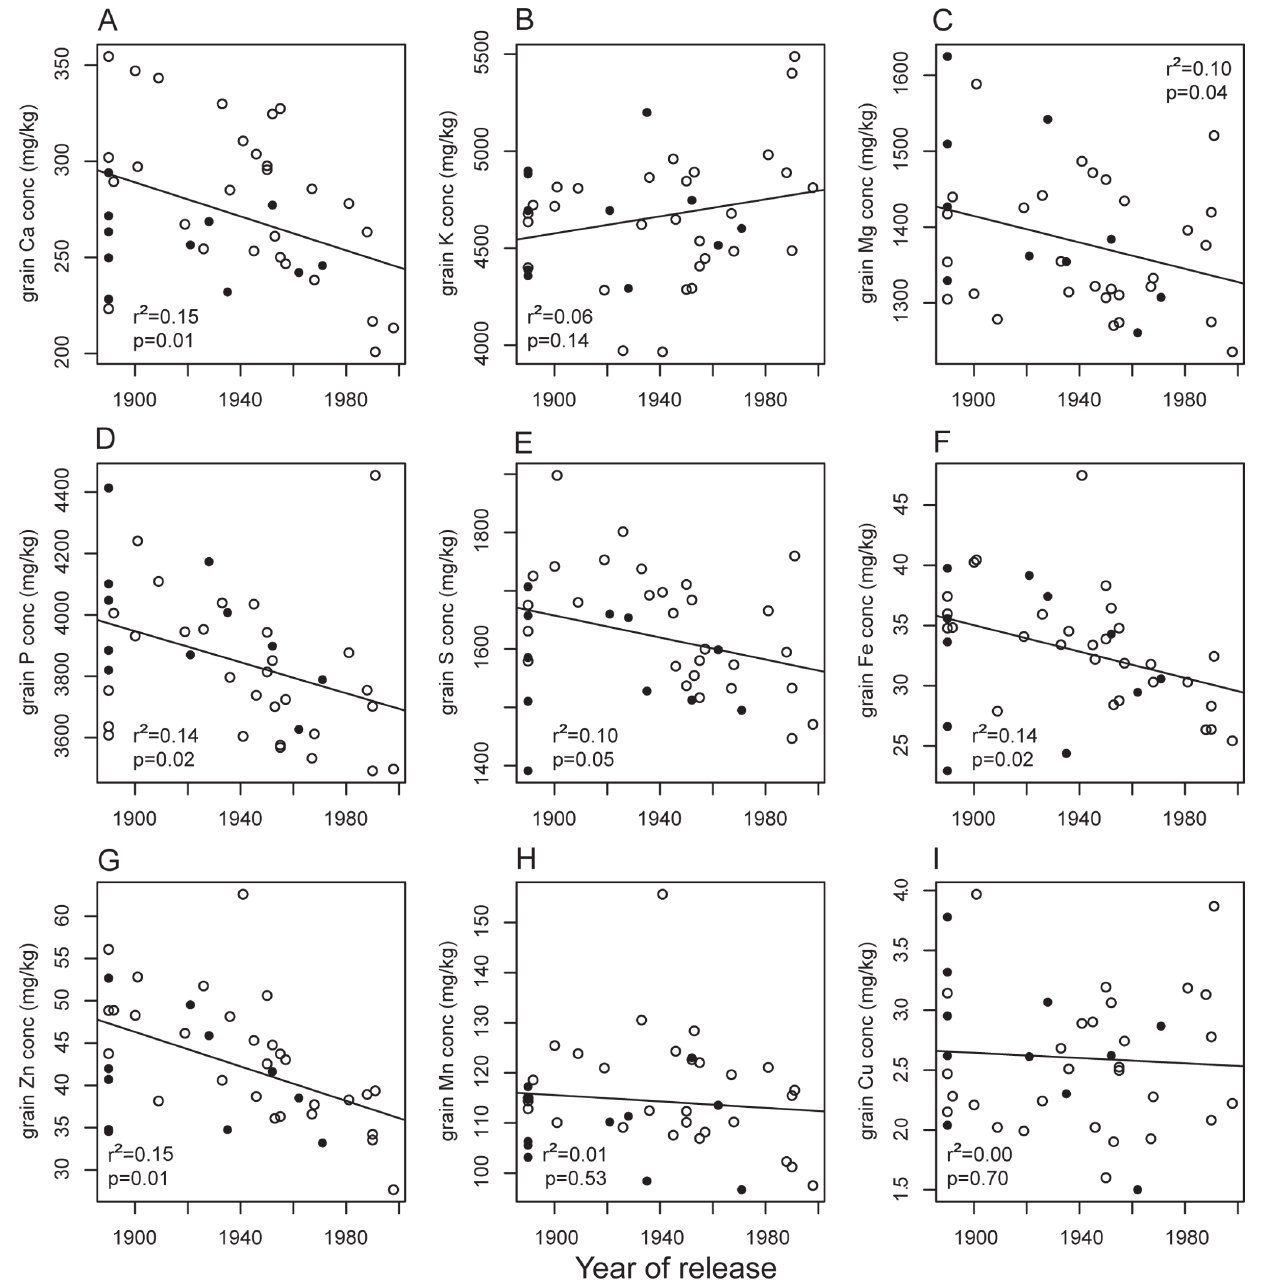
Figure 4. Changes in grain mineral concentrations over time. Filled circles are varieties with the wildtype allele of NAM-B1 , open circles are varieties with the deletion. The graph indicates grain concentrations of A) calcium, B) potassium, C) magnesium, D) phosphorus, E) sulfur, F) iron, G) zinc, H) manganese, and I) copper.